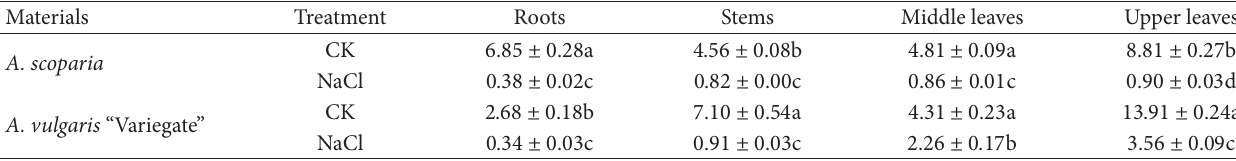
Table 5: Effect of NaCl stress on the ratios of K + /Na + in different parts of seedlings.